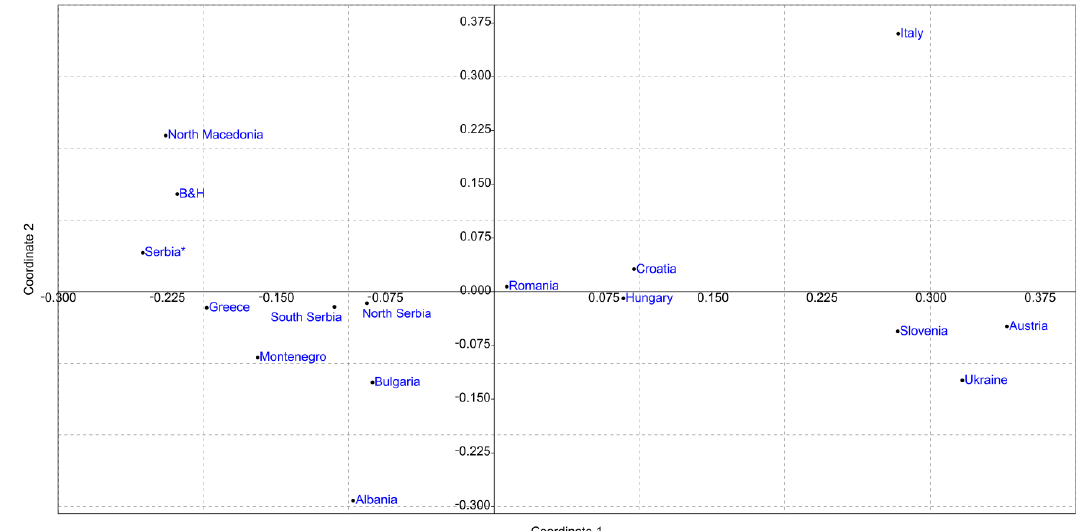
Figure 4. Nonmetric multidimensional scaling plot of F ST pairwise distances between the A. mellifera population of Serbia, two regions (North and South) and historical data (Serbia), and other A. mellifera populations based on the analysis of the variability of tRNA leu -cox2 intergenic region. The goodness of fit is expressed with the stress value which is 0.1229 for this dataset. Population pairwise F ST values are presented in Table S5b.